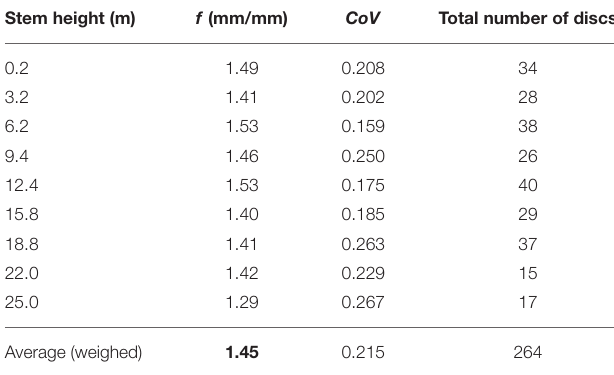
Bold result corresponding to the representative natural frequency of the whole coconut palm stem-tissue.